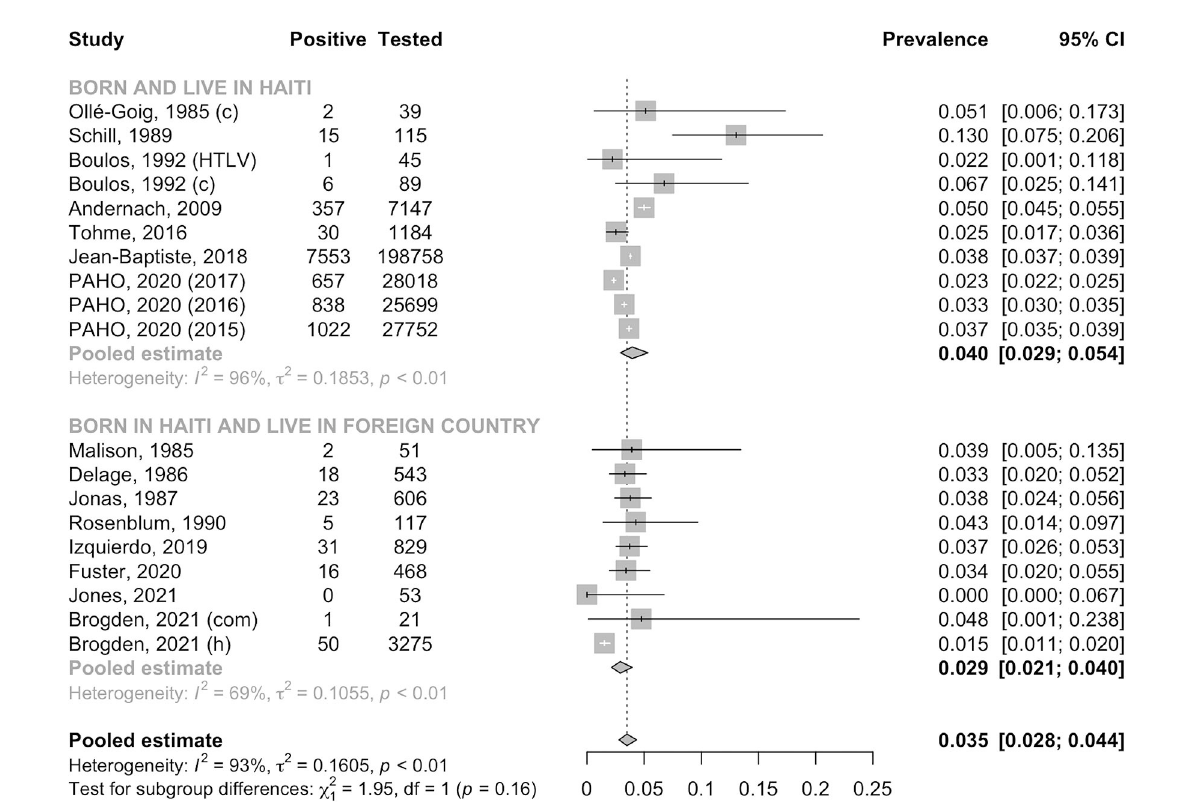
FIGURE4 Prevalence of HBsAg in the general adult population by place of residence. a, ascites group; c, control group; com, community recruitment; h, hospital recruitment; HIV, human immunodeficiency virus positive group; HTLV, human T-cell lymphotropic virus positive group; PAHO, Pan American Health